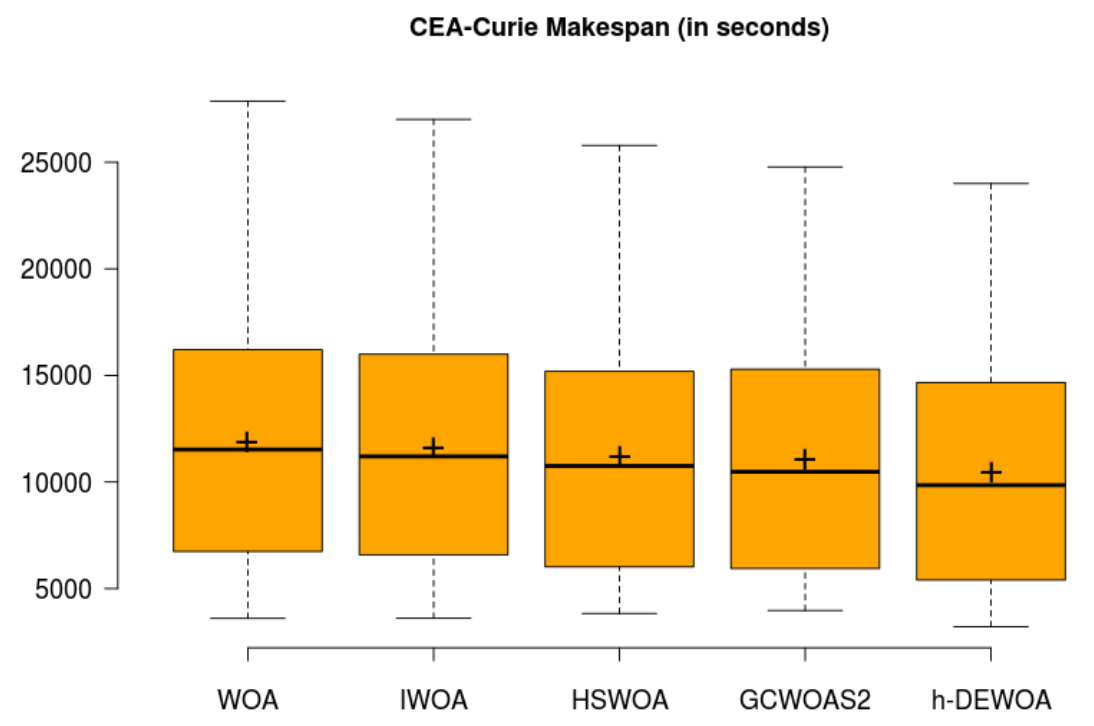
Figure 11. Comparative boxplot analysis of the overall makespan of h-DEWOA- and WOA-based scheduling algorithms for CEA-Curie workloads.